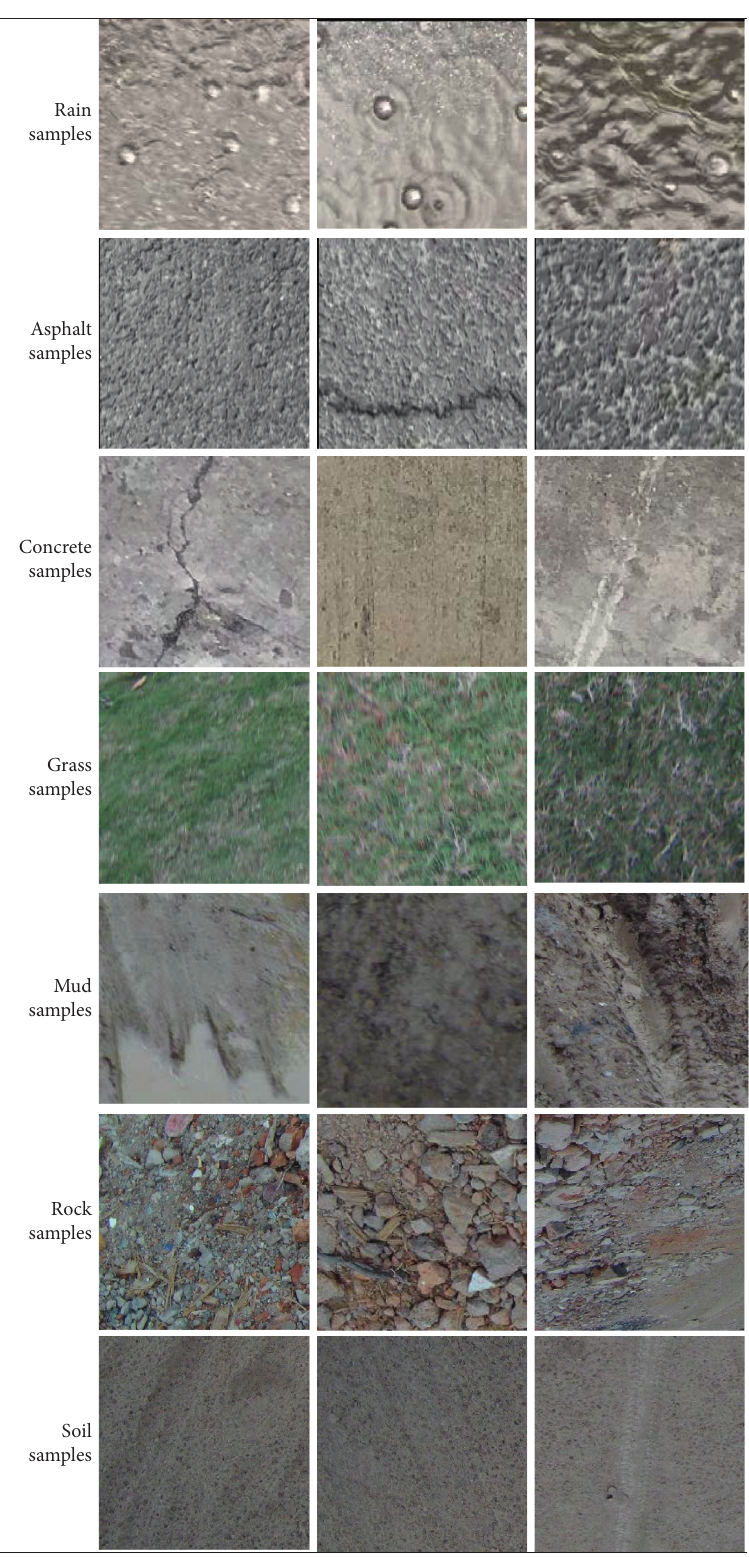
Figure 4: Image samples of road surface